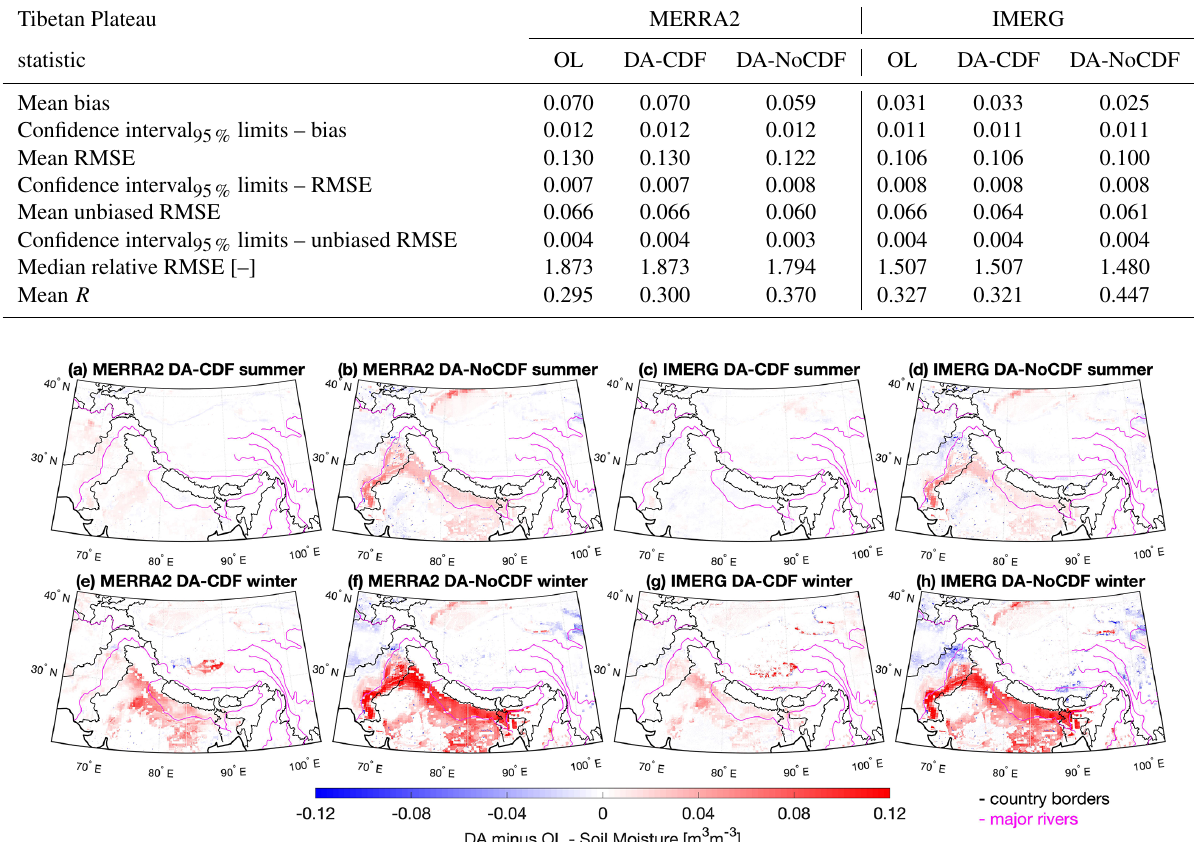
Figure 4. Differences between the mean soil moisture estimated by the OL and DA simulations during the summer (April to September 2016) versus the winter months (October 2015 to March 2016) highlight (1) the unmodeled irrigation signal across croplands and (2) the relatively higher influence of assimilation on soil moisture estimates during the winter period as compared to the summer period. DA-CDF is the assimilation of CDF-matched SMAP retrievals, and DA-NoCDF is assimilation without CDF matching of SMAP retrievals.